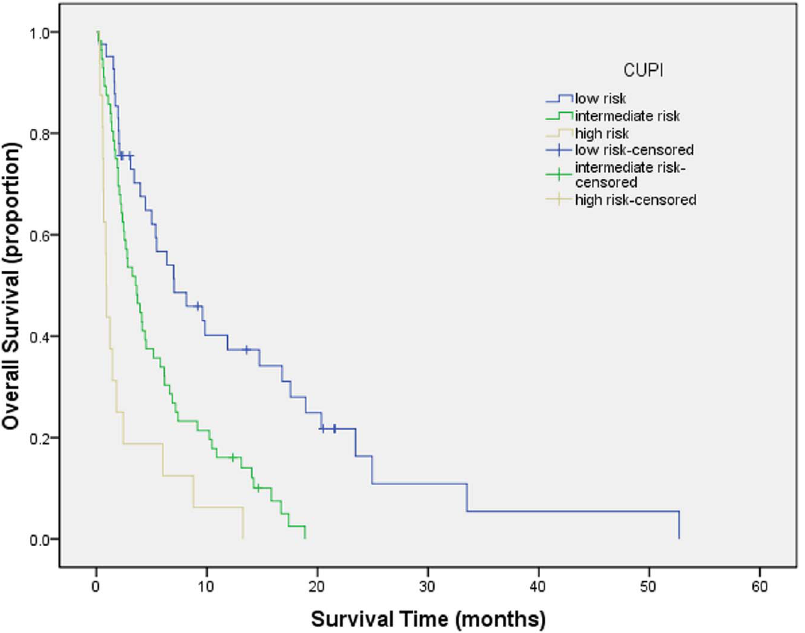
Figure 5. Survival curves for patients with unresectable hepatocellular carcinoma who stratified according to the Chinese University Prognostic Index. Low risk versus intermediate risk, P=.013; intermediate risk versus high risk, P=.000; low risk versus high risk, P=.000. All differences between scores were statistically significant.